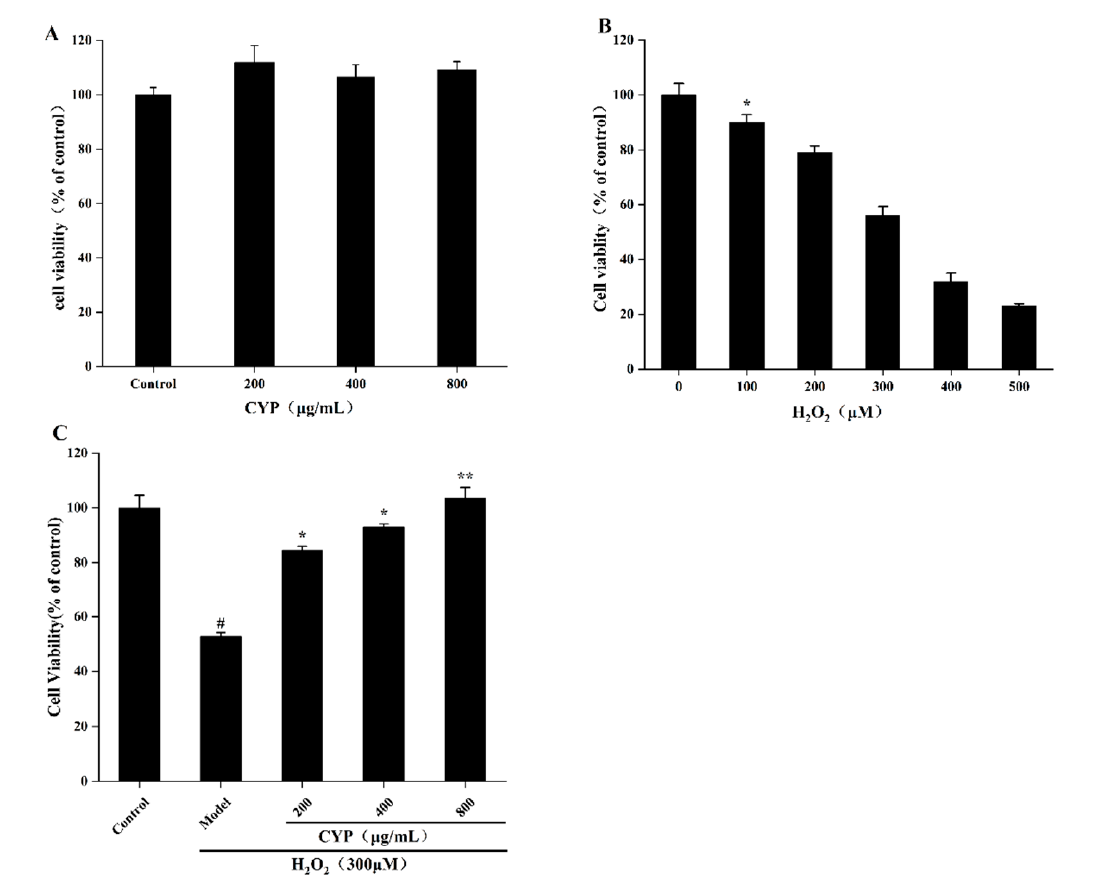
Figure 3. ( A ) Toxicity test of CYP on cell viability of IEC-6 cells (% of control), ( B ) Effects of H 2 O 2 on cell viability of IEC-6 cells (% of control), ( C ) Effects of CYP on cell viability in H 2 O 2 -injured IEC-6 cells (% of control). Results shown are expressed as means ± SD ( n = 3). # p < 0.05 compared with normal group, * p < 0.05 compared with H 2 O 2 group alone ** p < 0.01 compared with H 2 O 2 group alone.